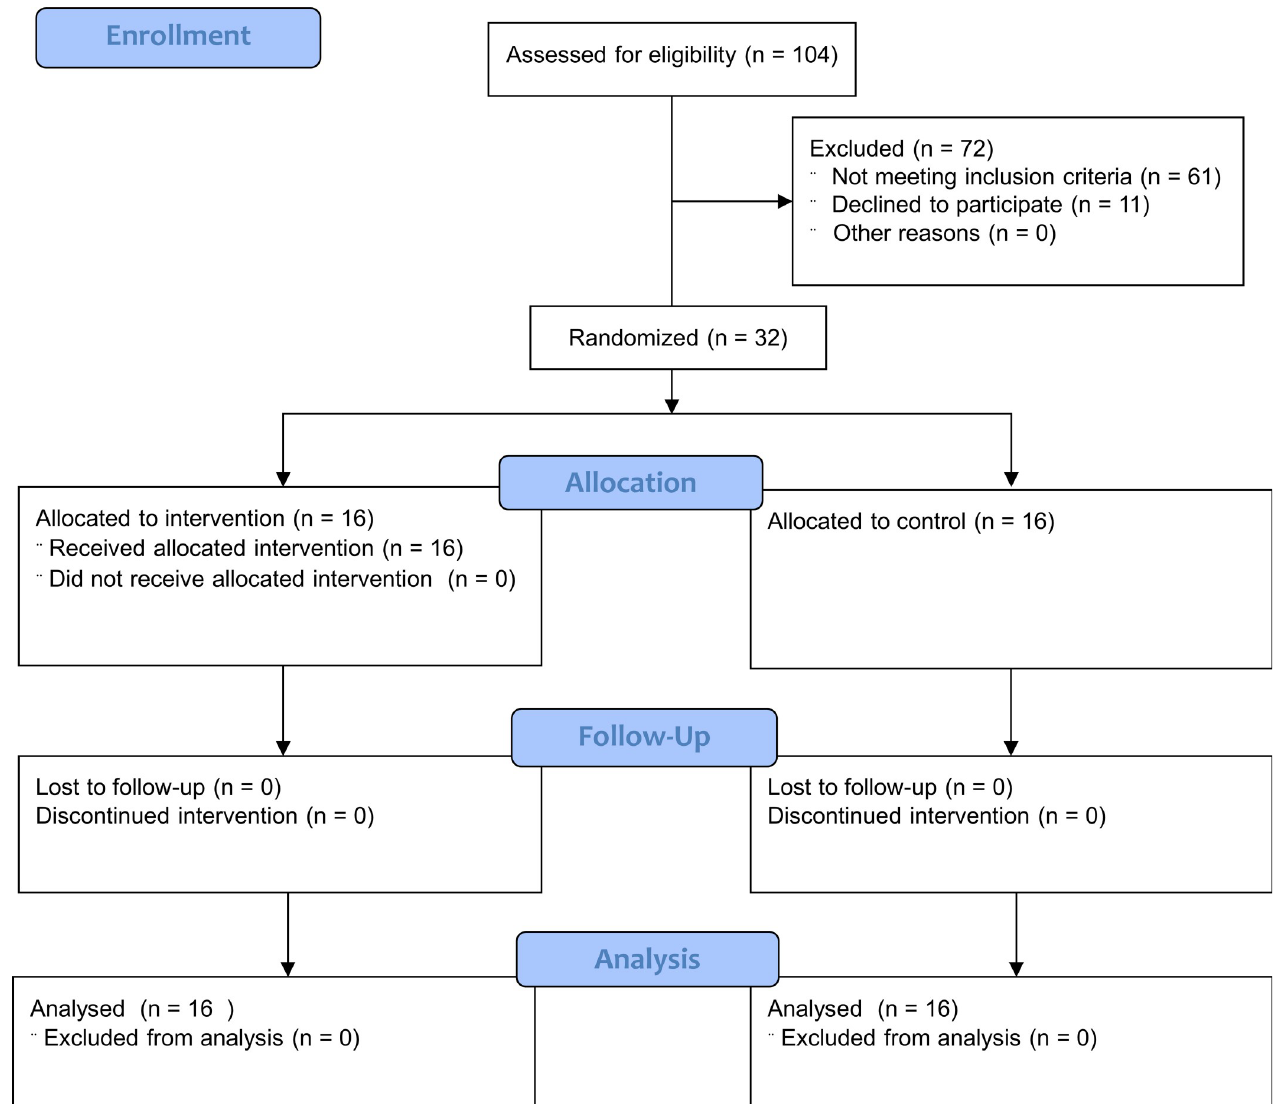
Fig 1. CONSORT flow chart diagram for enrollment, allocation, follow-up, and data analysis.